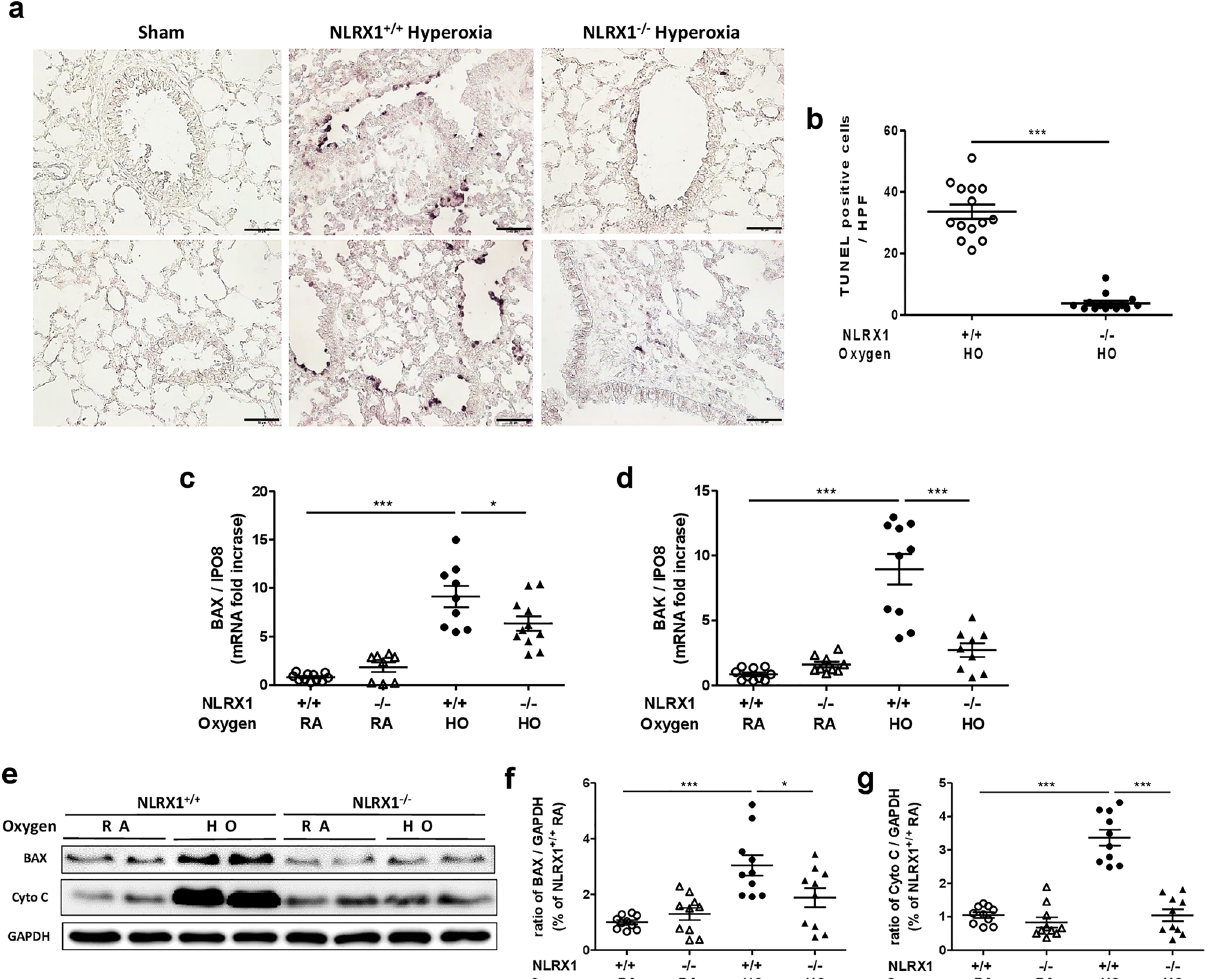
Figure 3. Absence of NLRX1 decreases the number of apoptotic cells and signaling molecules under hyperoxic conditions. ( A ) NLRX1 +/+ room air (sham), NLRX1 +/+ hyperoxia, and NLRX1 −/− hyperoxia mice lung sections were stained using TUNEL assay and ( B ) TUNEL-positive cells were counted. Scale bars 50 µm. ( C , D ) mRNA levels of Bax and Bak were measured by real-time PCR. () Protein levels of BAX and Cytochrome C (Cyto C) were analyzed using western blot of lung lysates, and ( F , G ) the ratio of molecules was calculated. Results are presented as the mean ± SEM and are representative of at least three independent experiments (n = 5 mice per group for real-time PCR and n = 2 mice per group for western blot). The images of the original blots are available in Supplementary Information. Some blots were cut prior to hybridization with antibodies. * p < 0.05, *** p < 0.001 (Student’s t